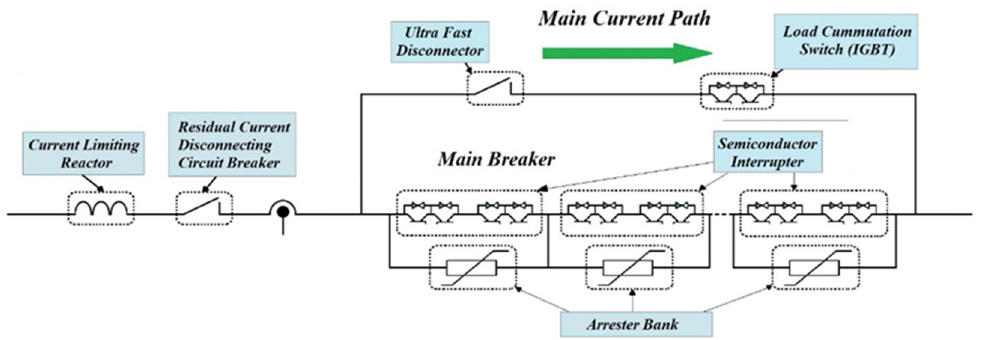
Figure 18. Hybrid circuit breaker.